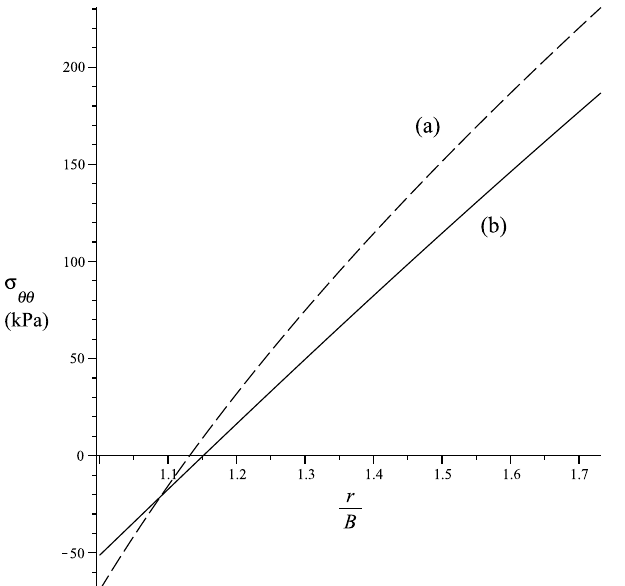
Figure 5. Radial behaviour of stress σ θθ . ( a ) Elastic solid with fibre bending resistance. ( b ) Elastic solid with no fibre bending